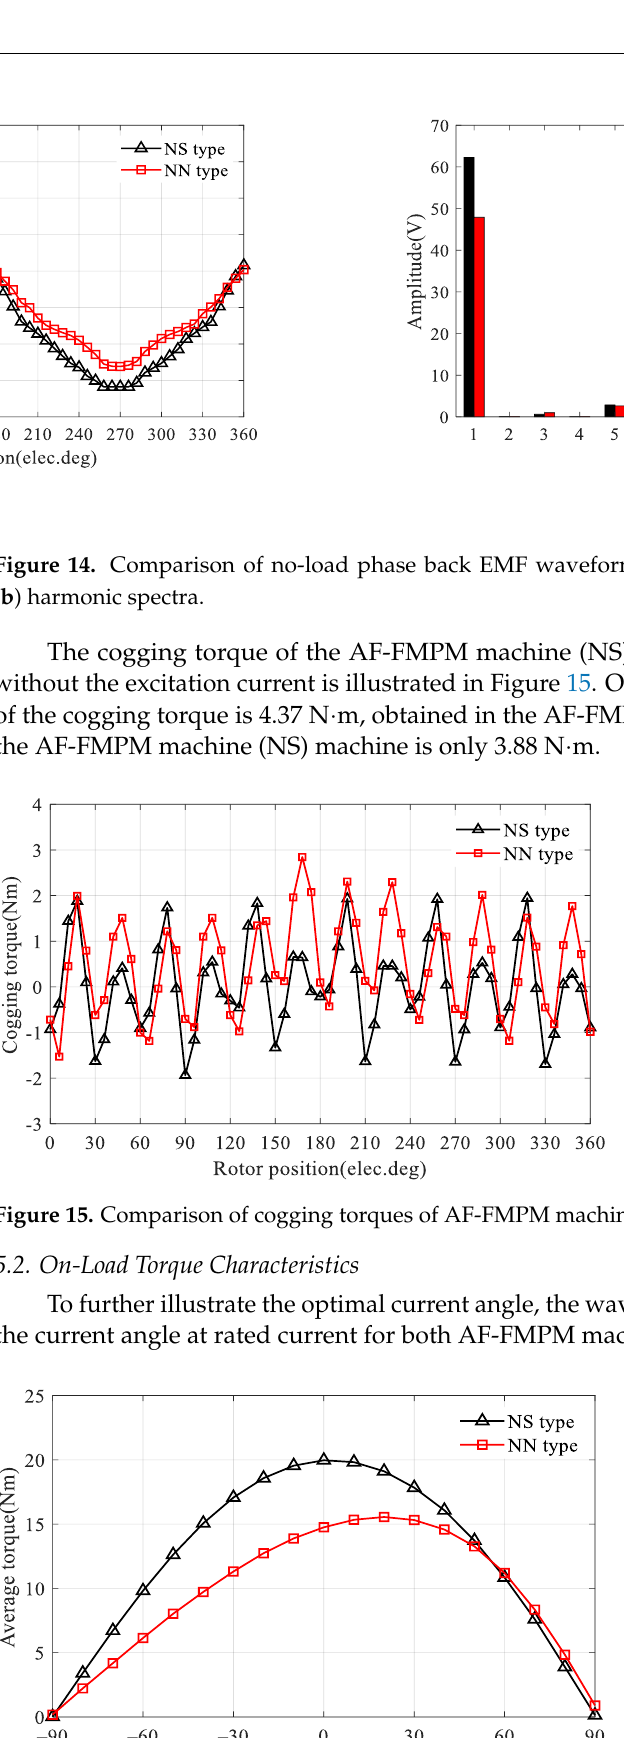
Figure 16. Variation of average torque with current angle in AF-FMPM machines.